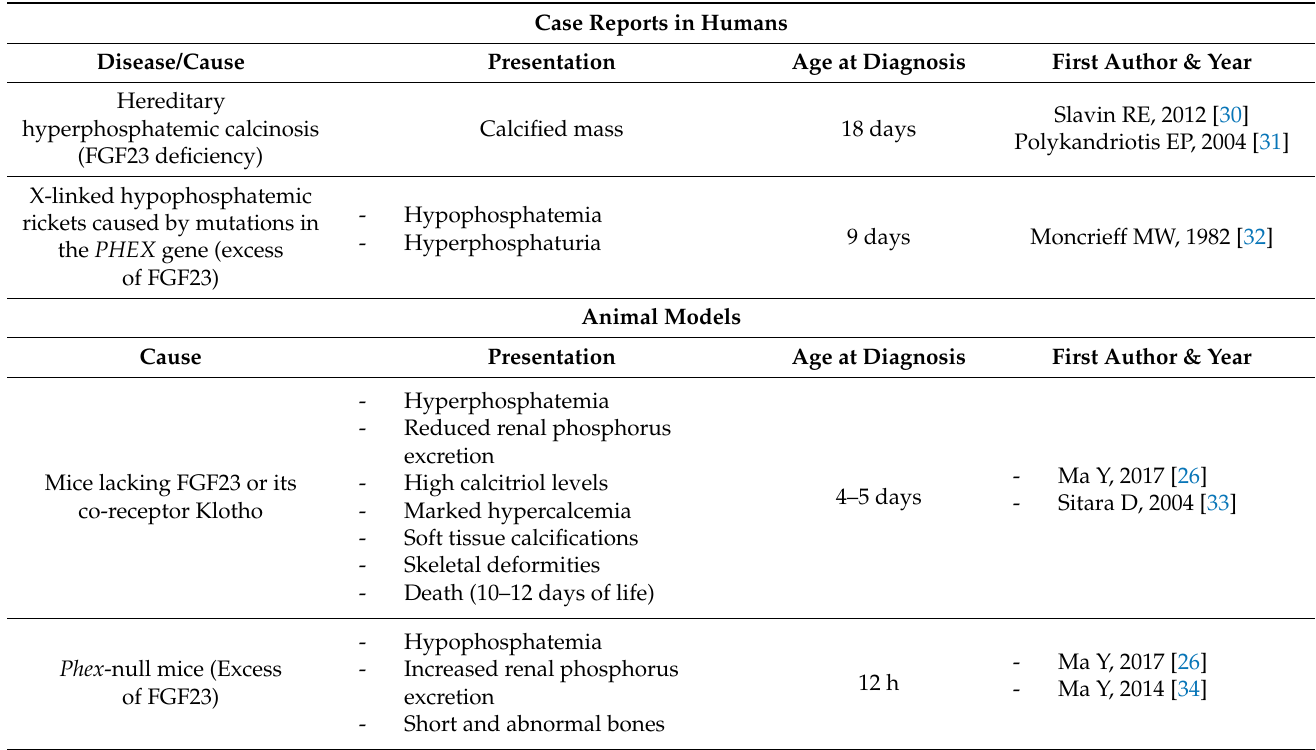
Table 2. Publications showing early manifestations induced by fibroblast growth factor 23 (FGF23) deficiency or excess in clinical case reports or animal models